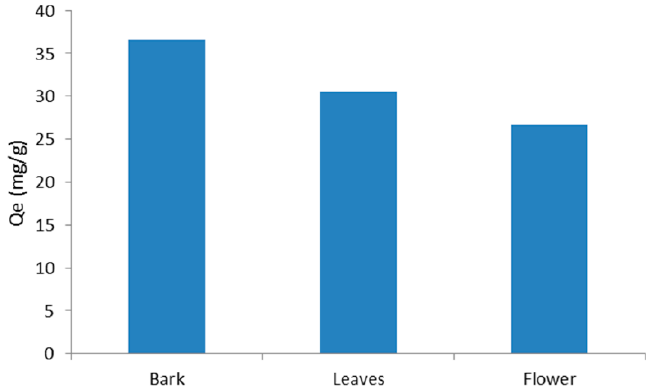
Figure 7. Adsorption of MR dye by bark, leaves, and flowers of D. viscose plant.